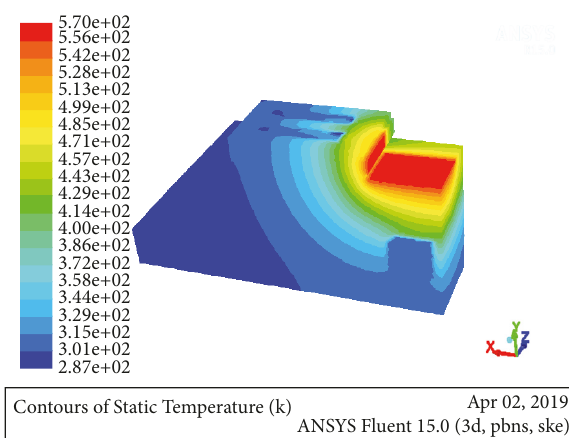
Figure 9: The temperature distribution of support in Test B1.